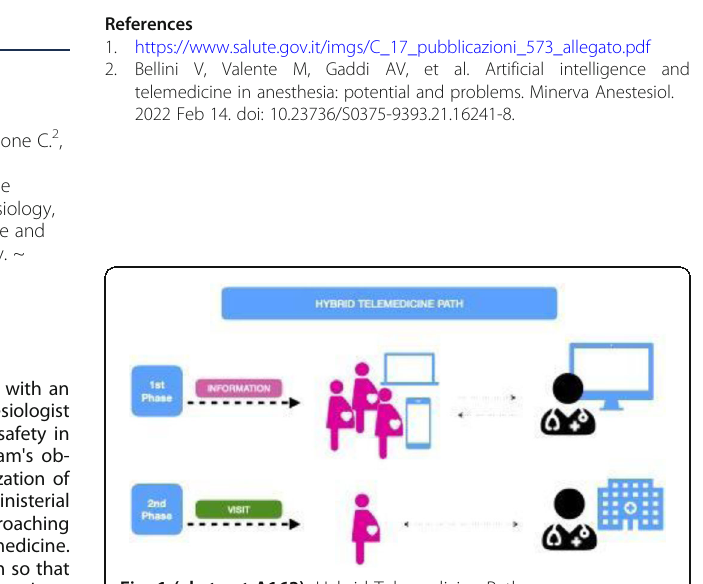
Fig. 1 (abstract A163). Hybrid Telemedicine